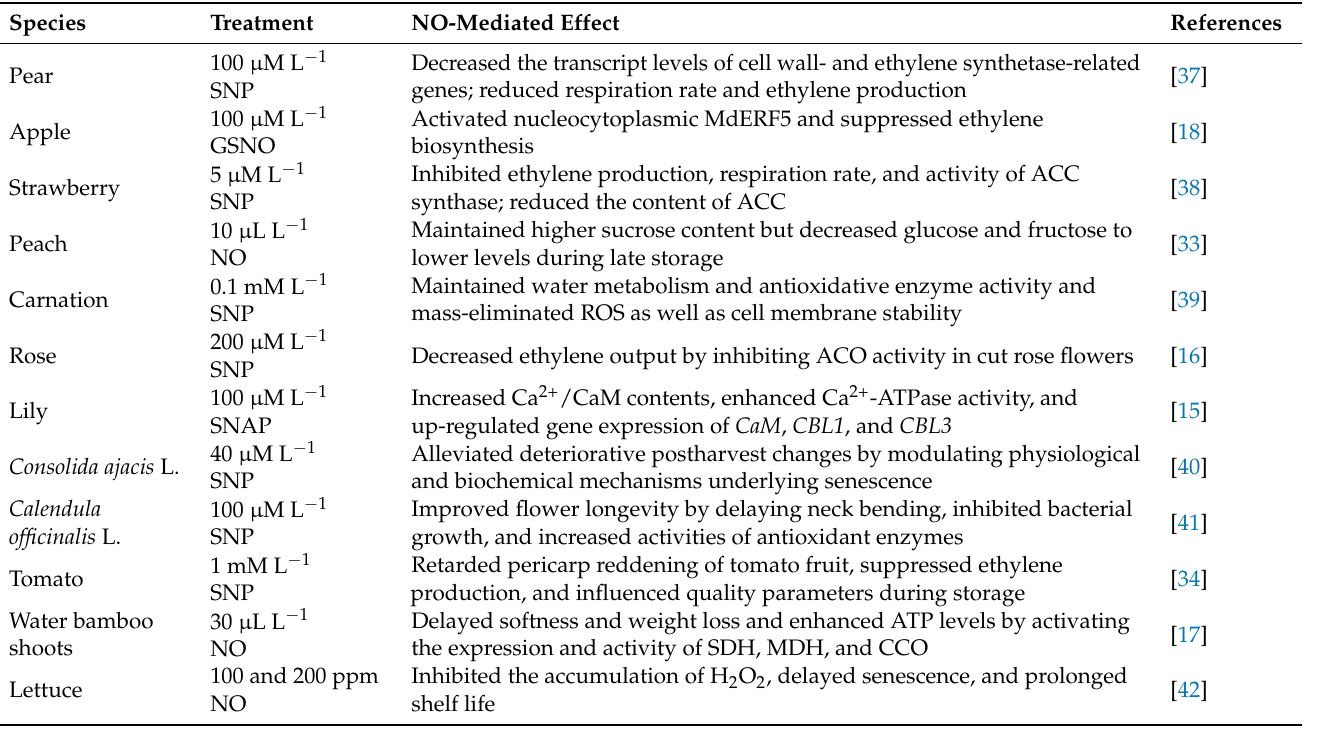
Table 1. Effects of NO on postharvest senescence in horticultural